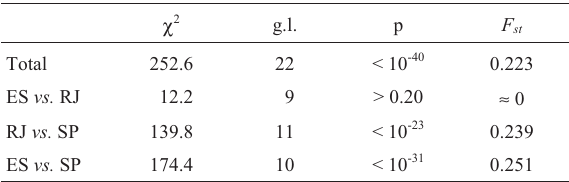
Table 2 - Contingency table results, and pairwise estimation of F ST between the populations of sea-bob from Ubatuba (SP), Cabo Frio (RJ) and Nova Almeida